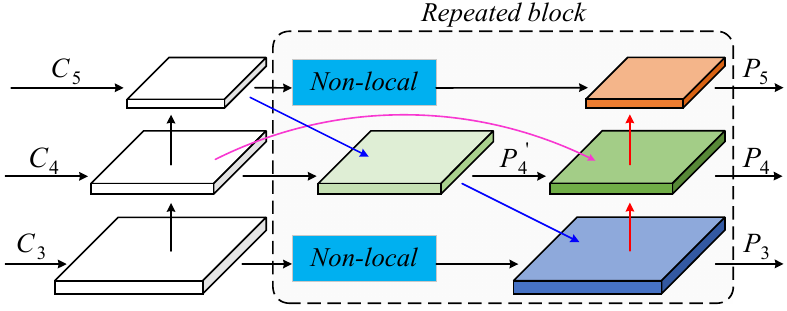
Figure 7. The structure of WCFF module. The non-local network is embedded in the edge